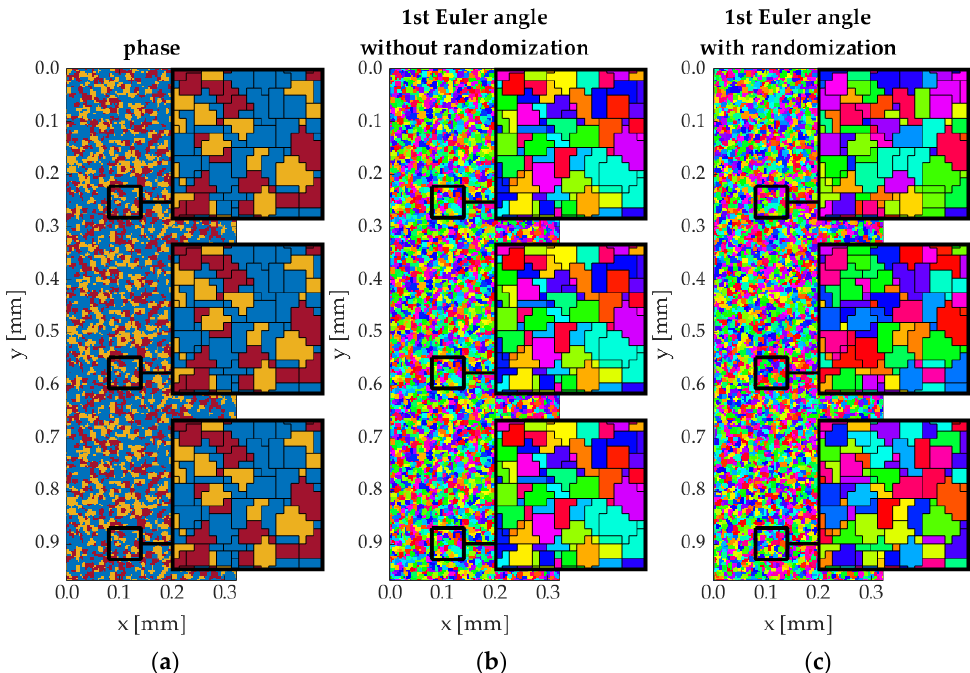
Figure 3. An example of replication and randomization. On the left ( a ), the phase is shown, replicated three times in 𝑦 -direction. The middle image ( b ) shows an ordinary replication of the first Bunge Euler angle. Note the repetitive patterns in the zooms. The image on the right ( c ) shows the results of Euler angle randomization per phase after replication, which eliminates the repetitive pattern in the texture. After randomization, the phases corresponding with ( c ) still remaining the same as in ( a ). The colors are corresponding with those used in Figure 2.